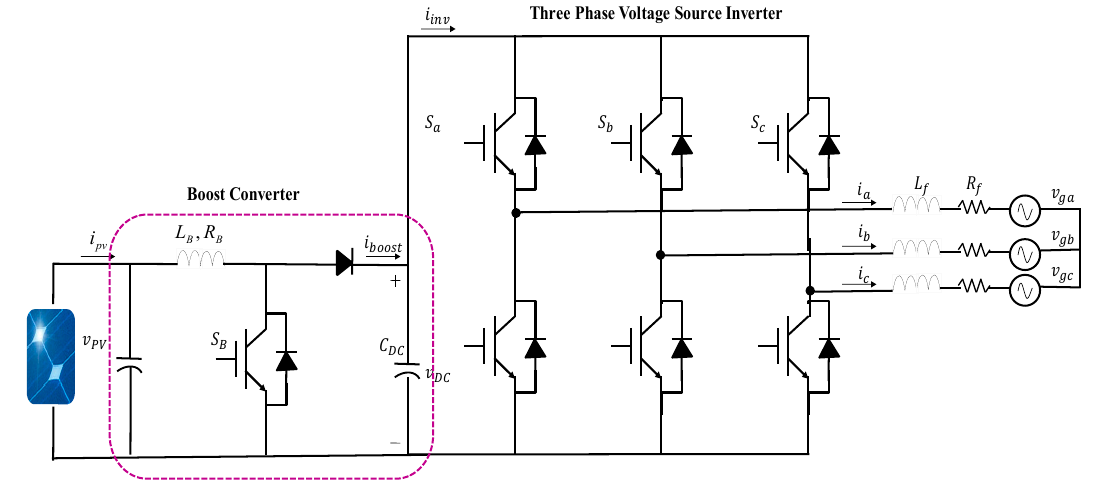
Figure 2. The topology of the grid-connected photovoltaic (PV) system.